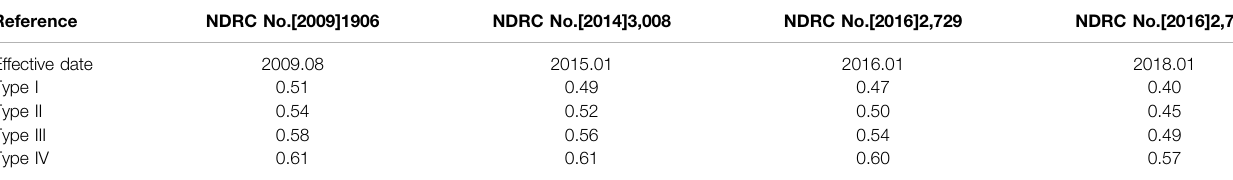
TABLE 3 | Wind power benchmarking price of four resource zones in China (yuan/kWh).